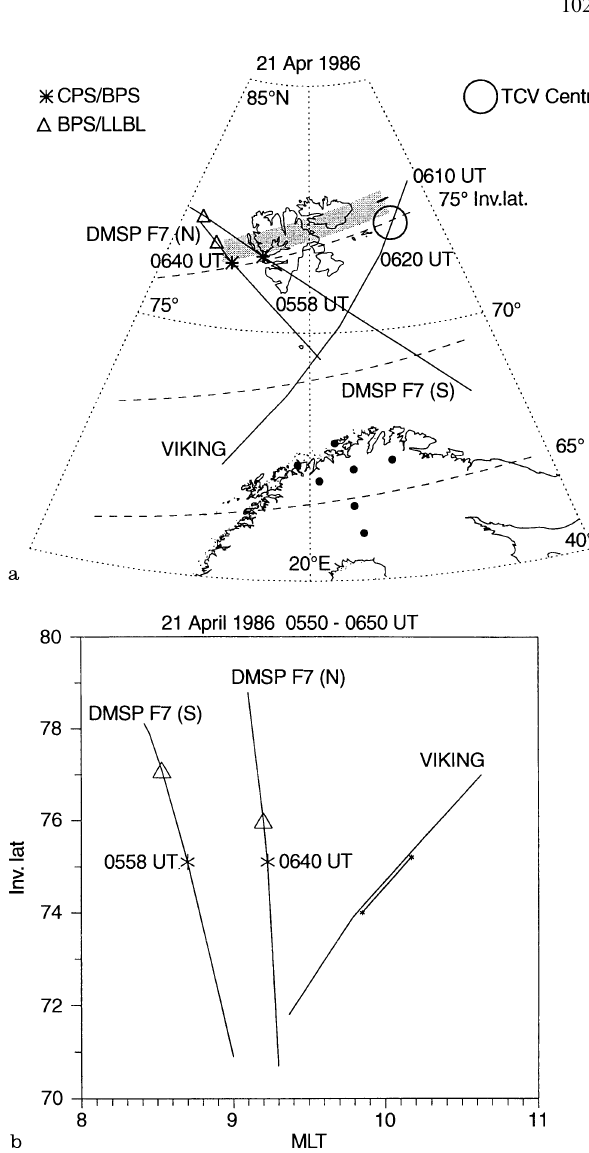
Fig. 2. a Geographic map of the magnetic stations ( small filled circles ) and the location of the TCV centres for the event of Vogel- sang et al . (1993). In addition, the VIKING and the DMSP satellite trajectories are displayed and on the latter the detected precipitation boundaries are marked according to the legend in the figure. For further details see the text. b The aforementioned satellite trajecto- ries including the locations of the precipitation boundaries, are displayed in the Inv. Lat.-MLT coordinate